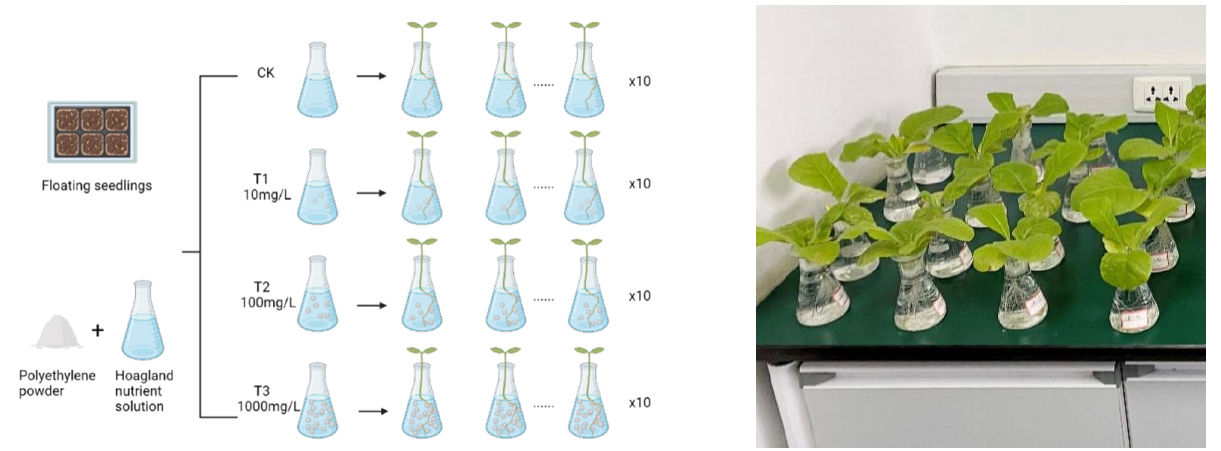
Figure 1. Schematic diagram of microplastic-stressed tobacco culture